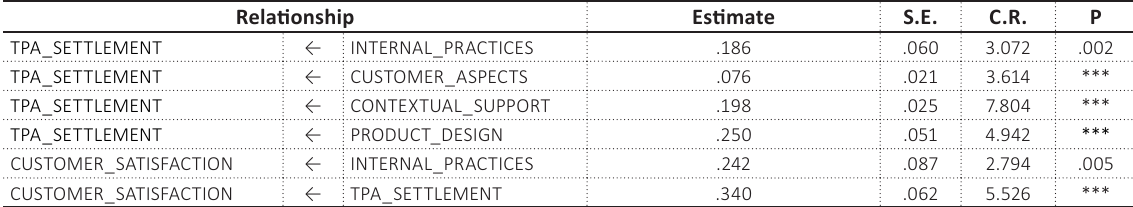
Table 4. Causal path relationship: Aggregate Relationship Estimate